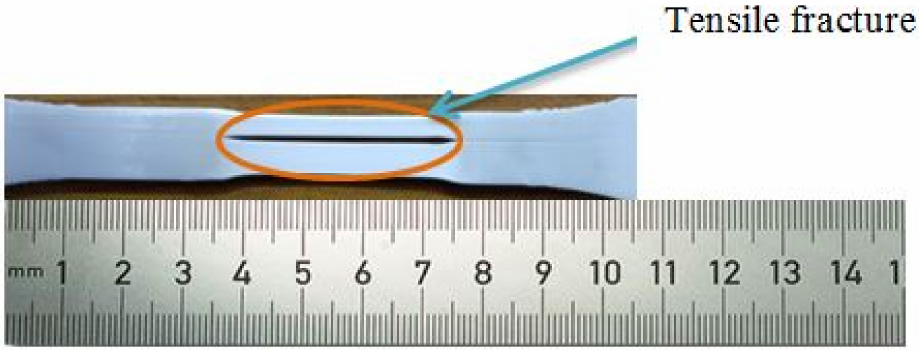
Figure 14. Tensile tested